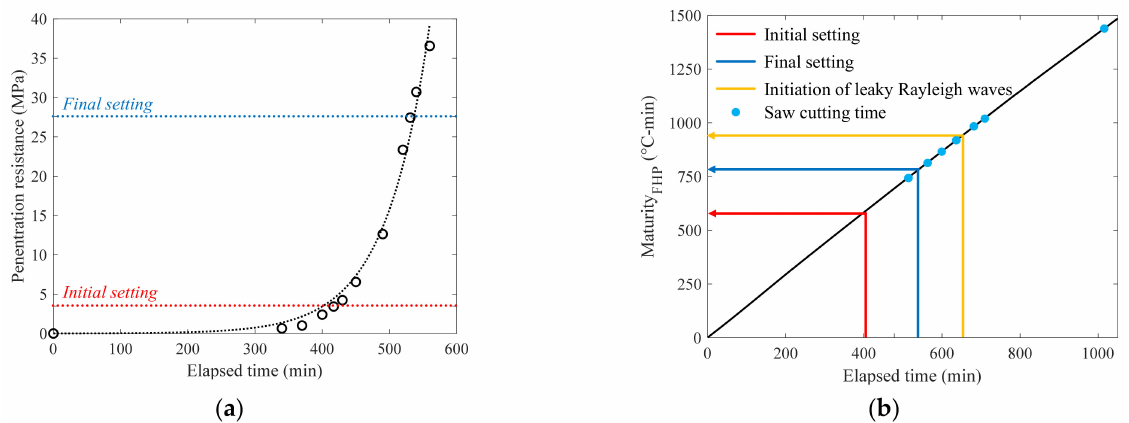
Figure 7. Test results from the ( a ) pin penetration test, and ( b ) maturity